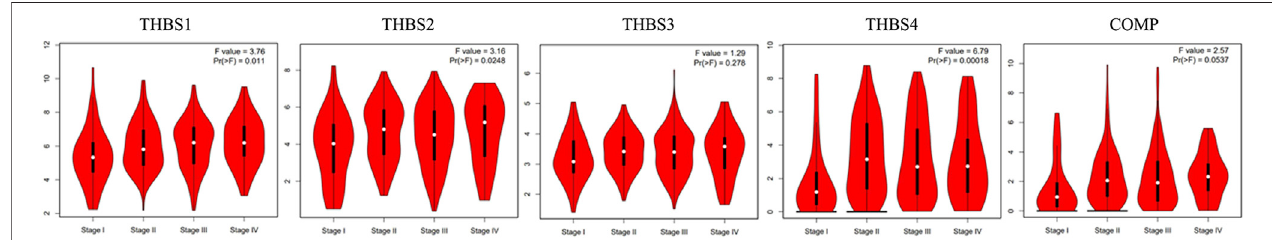
FIGURE 2 | Stage plot showing the correlation between THBSs expression with tumor stage in gastric cancer (GEPIA).